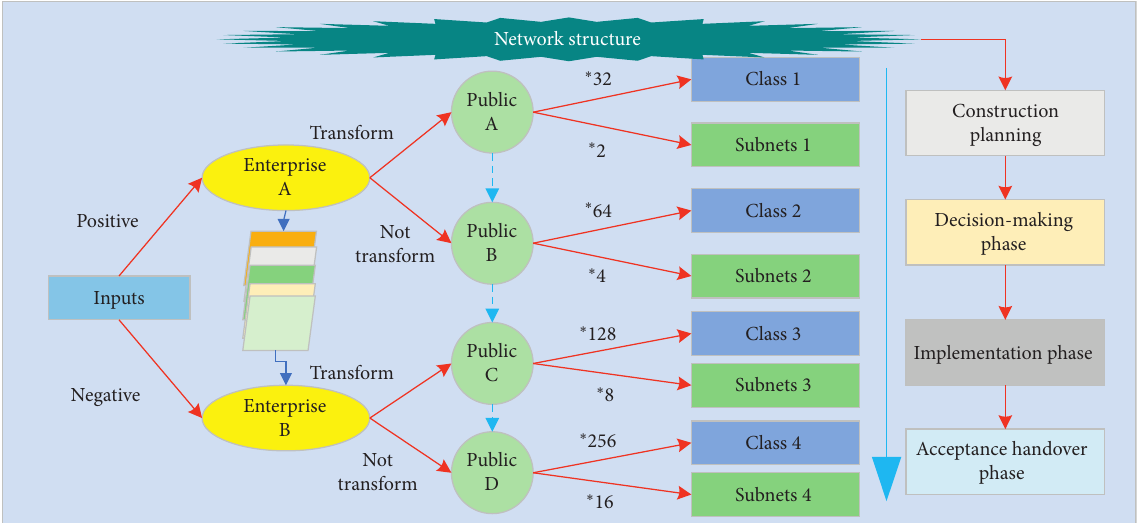
Figure 2: Network structure.